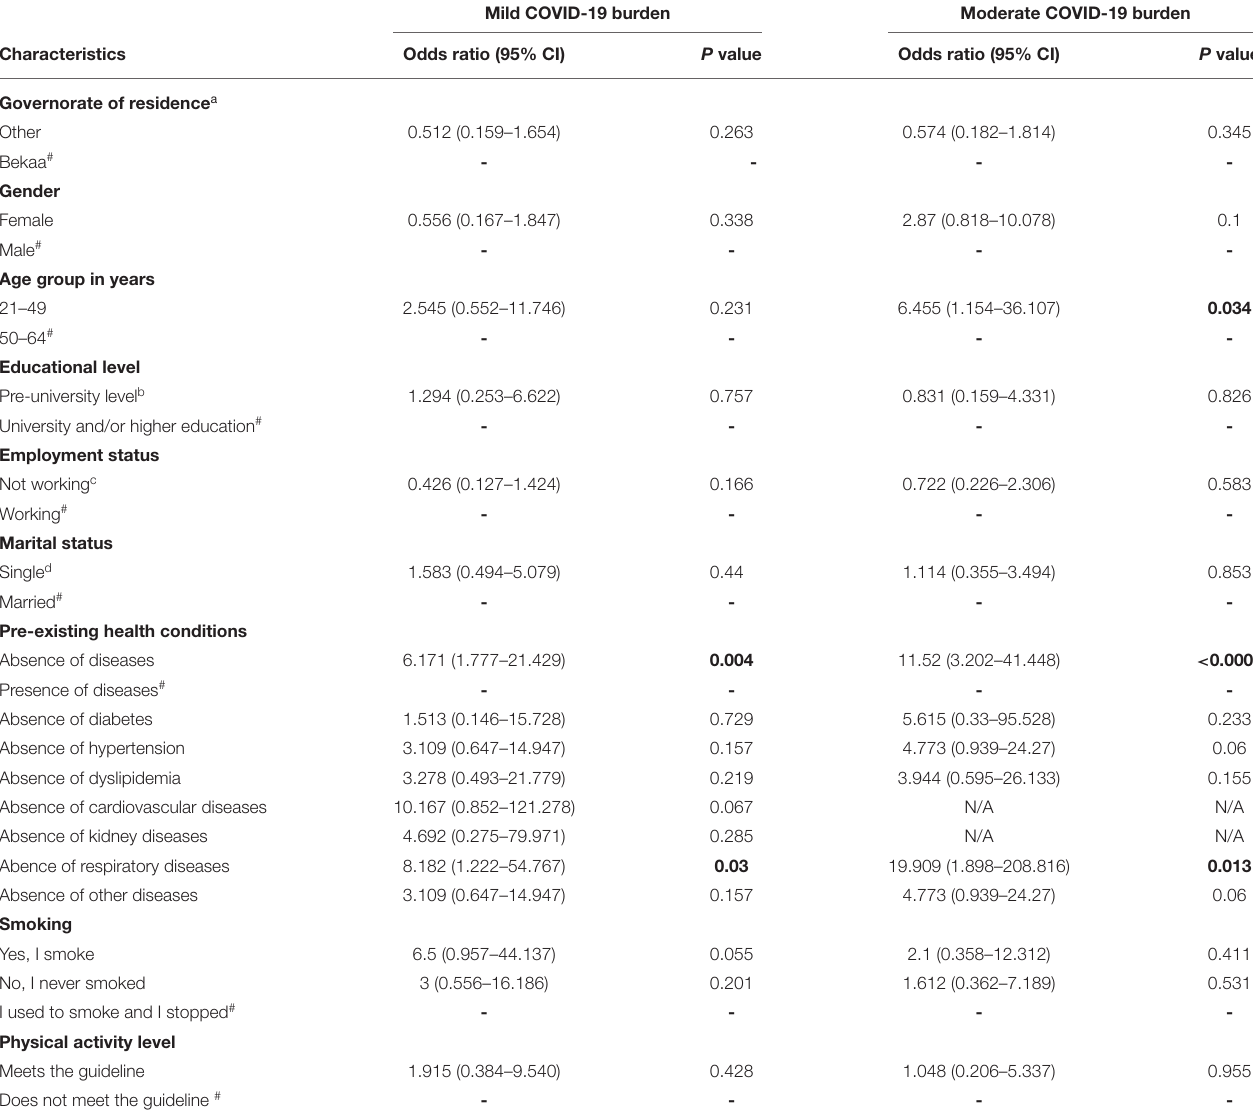
TABLE 8 | Multiple logistic regression for the association of selected study variables with the burden of COVID-19 among the case group. Mild COVID-19